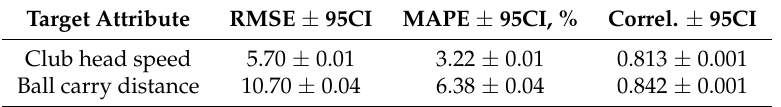
Table 5. Decision-level fusion for regression task: summary of results. Note: 95CI stands for 95% confidence interval (mean and corresponding 95% CI are obtained after repeating the task 100